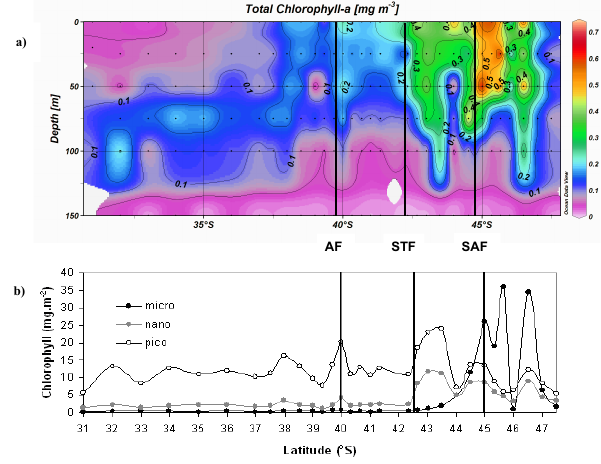
Fig. 6. (a) CTD total chlorophyll (mgm − 3 ) section to 150m with data points indicated as black dots and (b) size fractionated chloro- phyll distribution (mgm − 3 ) integrated over the top 150m for the Southbound Transect. The position of the three frontal systems are marked as bold vertical lines. The section was made using Ocean Data View (Schlitzer,